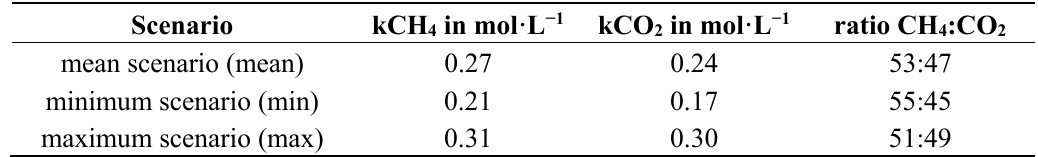
Table 4. Scenarios for the